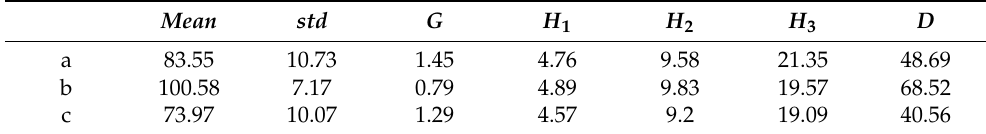
Table 3. The results of infrared feature extraction of these three